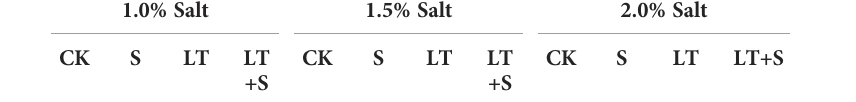
TABLE 1 Photosynthetic parameters deduced by the JIP-test analysis of fl uorescence